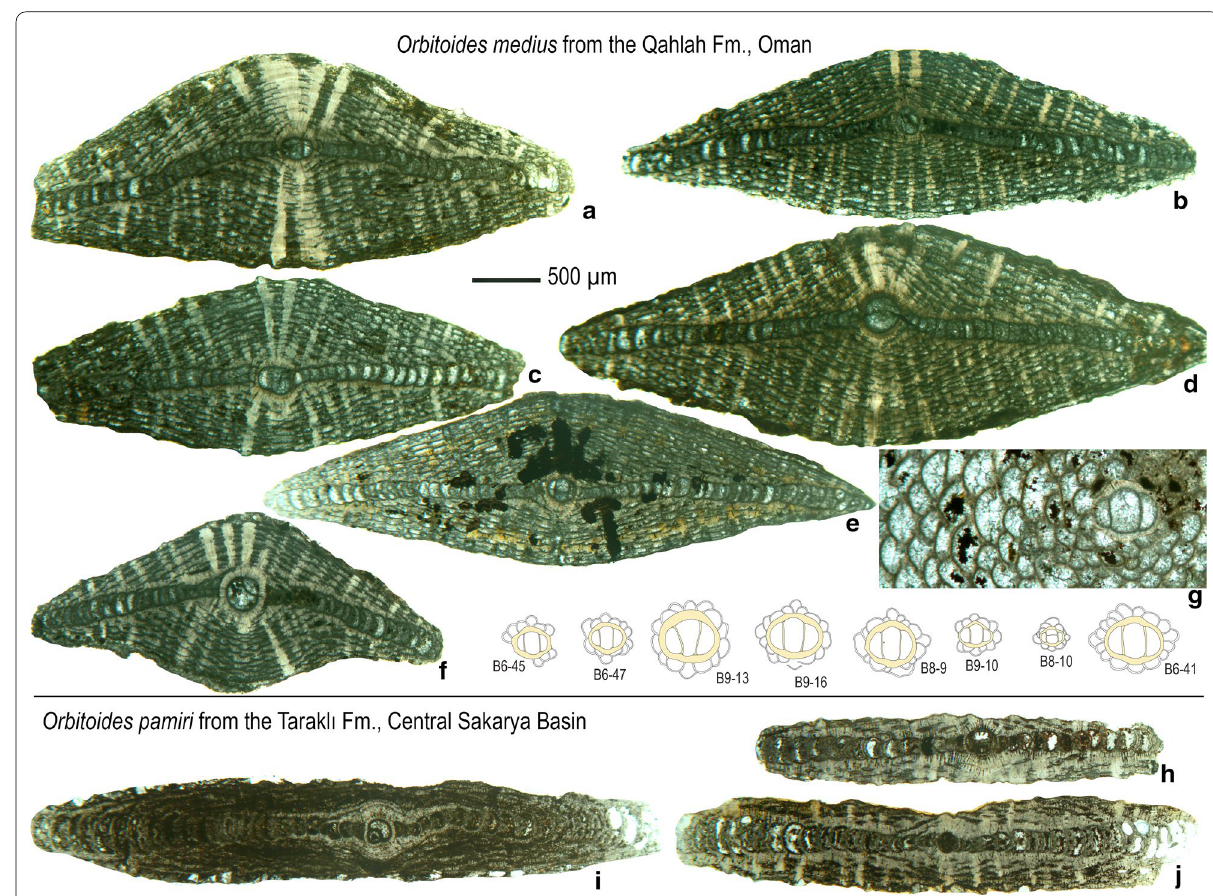
Fig. 21 Comparison of the axial and near axial sections of the upper Campanian Orbitoides medius from the Qahlah Formation from Oman ( a–f ) and O. pamiri from the upper Maastrichtian Taraklı Formation ( h–j ). An equatorial section of O. medius is shown in ( g ). Line drawings of the embryonic-nepionic stages of some O. medius specimens are also illustrated. Note that specimens from the Qahlah Formation are invariably biconvex and consist of numerous cycles of lateral chamberlets, whereas those from the Taraklı Formation ( O. pamiri ) are flat to biconcave with few cycles of lateral chamberlets. Refer to Kayğılı et al. (2021) for the detailed description of O. medius from Qahlah Formation. a B6-10. b B6-20. c B6-11. d B6-14. e B6-22. f B6-19, g B8-8. h EPB5-5. i EPB5-2. j